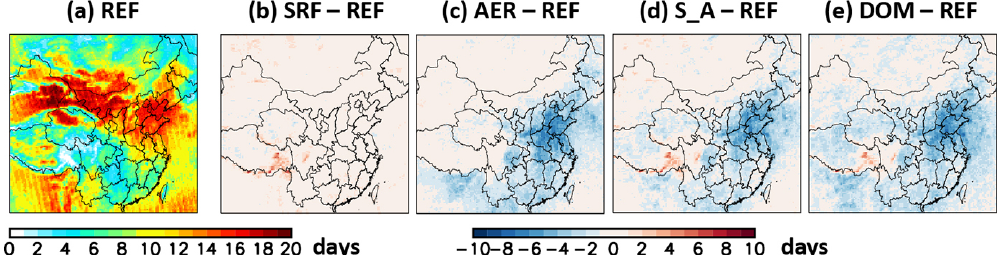
Figure 12. (a) Number of days per month of 2012 with valid pixels in case REF on a 0.25 ◦ long. × 0.25 ◦ lat. grid. (b) Changes in the number of days per month with valid pixels from REF to other cases. Provincial boundaries of China are